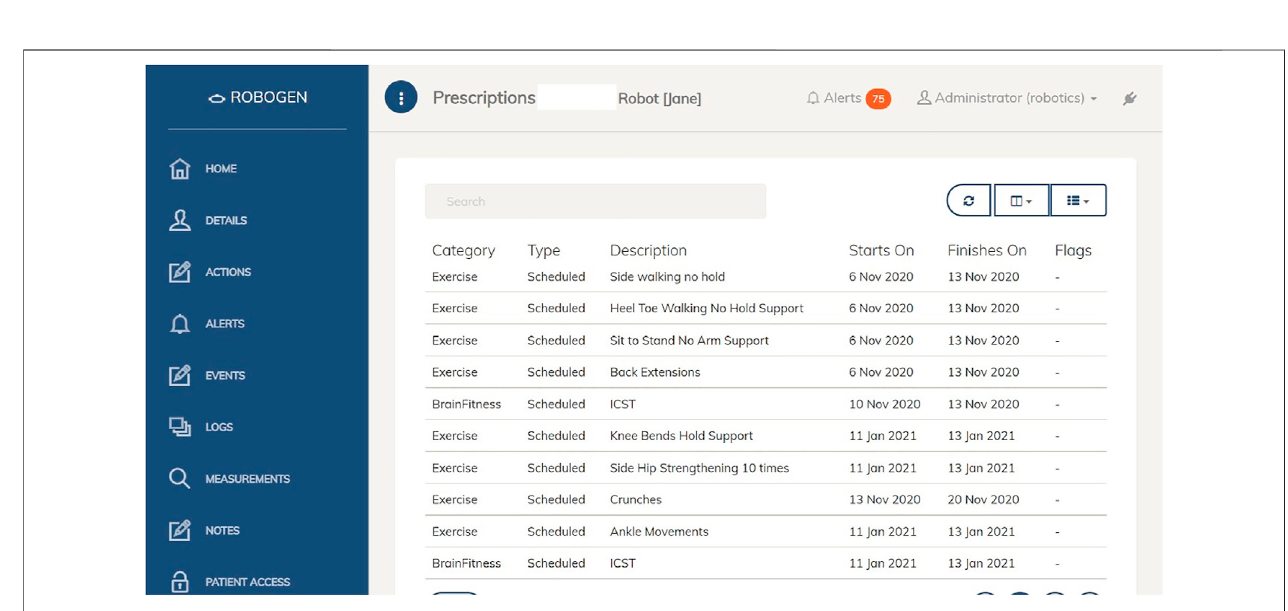
FIGURE 3 | RoboGen2 test patient exercise information.